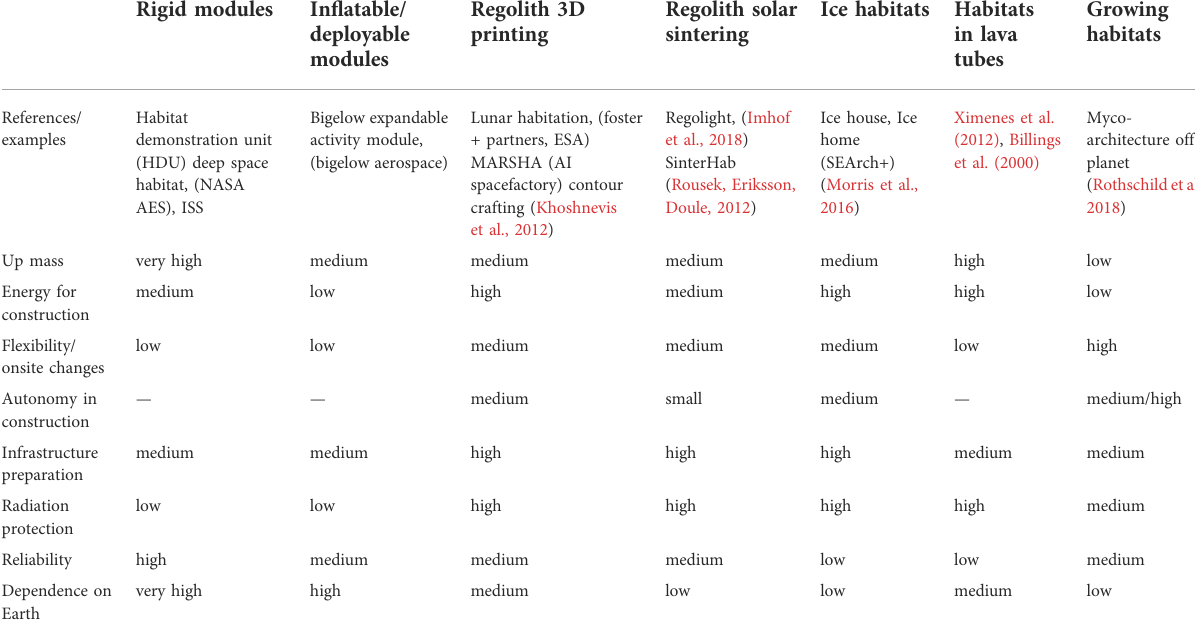
TABLE 1 Comparison of different construction strategies for lunar and Martian habitats (Billings et al., 2000; De Kastelier, 2012; Khoshnevis et al., 2012; Lyndon, 2012; Rousek et al., 2012; Ximens et al., 2012; Morris et al., 2016; Garcia, 2018; Imhof et al., 2018; Rothschild et al., 2018; AI SpaceFactory,